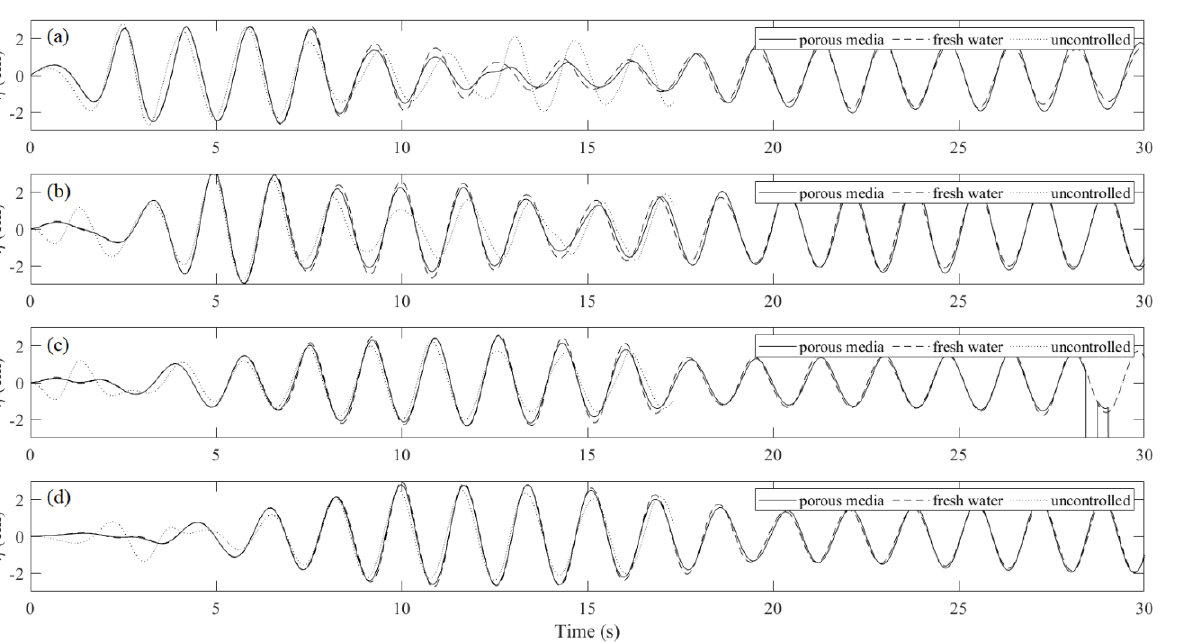
Figure 33. The wave elevations in the channel at the locations of: ( a ) x = 2 m; ( b ) x = 4 m; ( c ) x = 6 m; ( d ) x = 8 m.